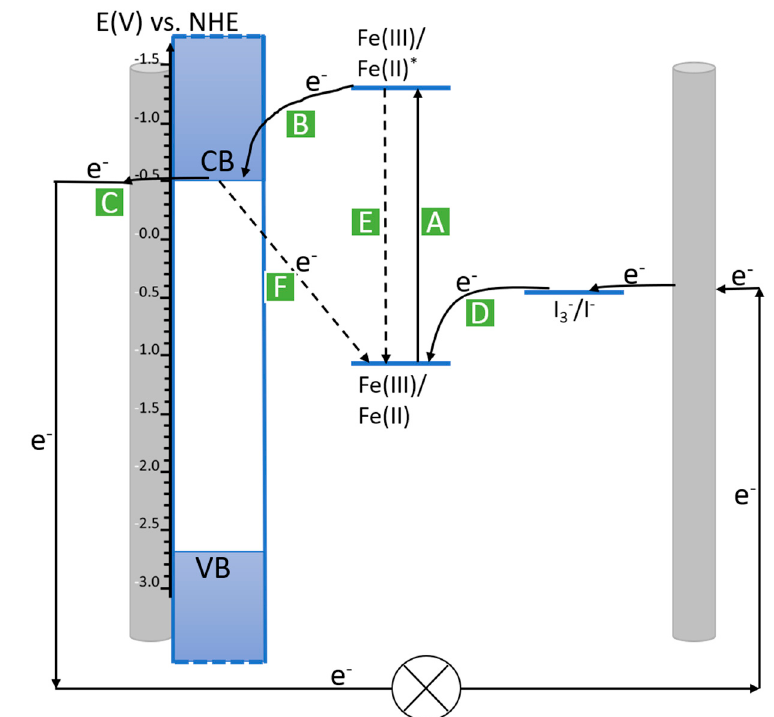
Figure 12. Schematic of an n-type dye-sensitized solar cell (DSSC) with incorporated redox potential scale. Fe(III)/Fe(II) is here exemplified by specific reduction potential for complex 5 as the photosensitizer, with Fe(III)/Fe(II)* as the corresponding excited state potential. I 3 − /I − is used as the redox mediator and TiO 2 as the semiconductor (CB—conduction band, VB—valence band). Key processes in the DSSC marked in the figure are: A—excitation, B—injection, C—extraction, D—regeneration, E—relaxation, F—recombination.